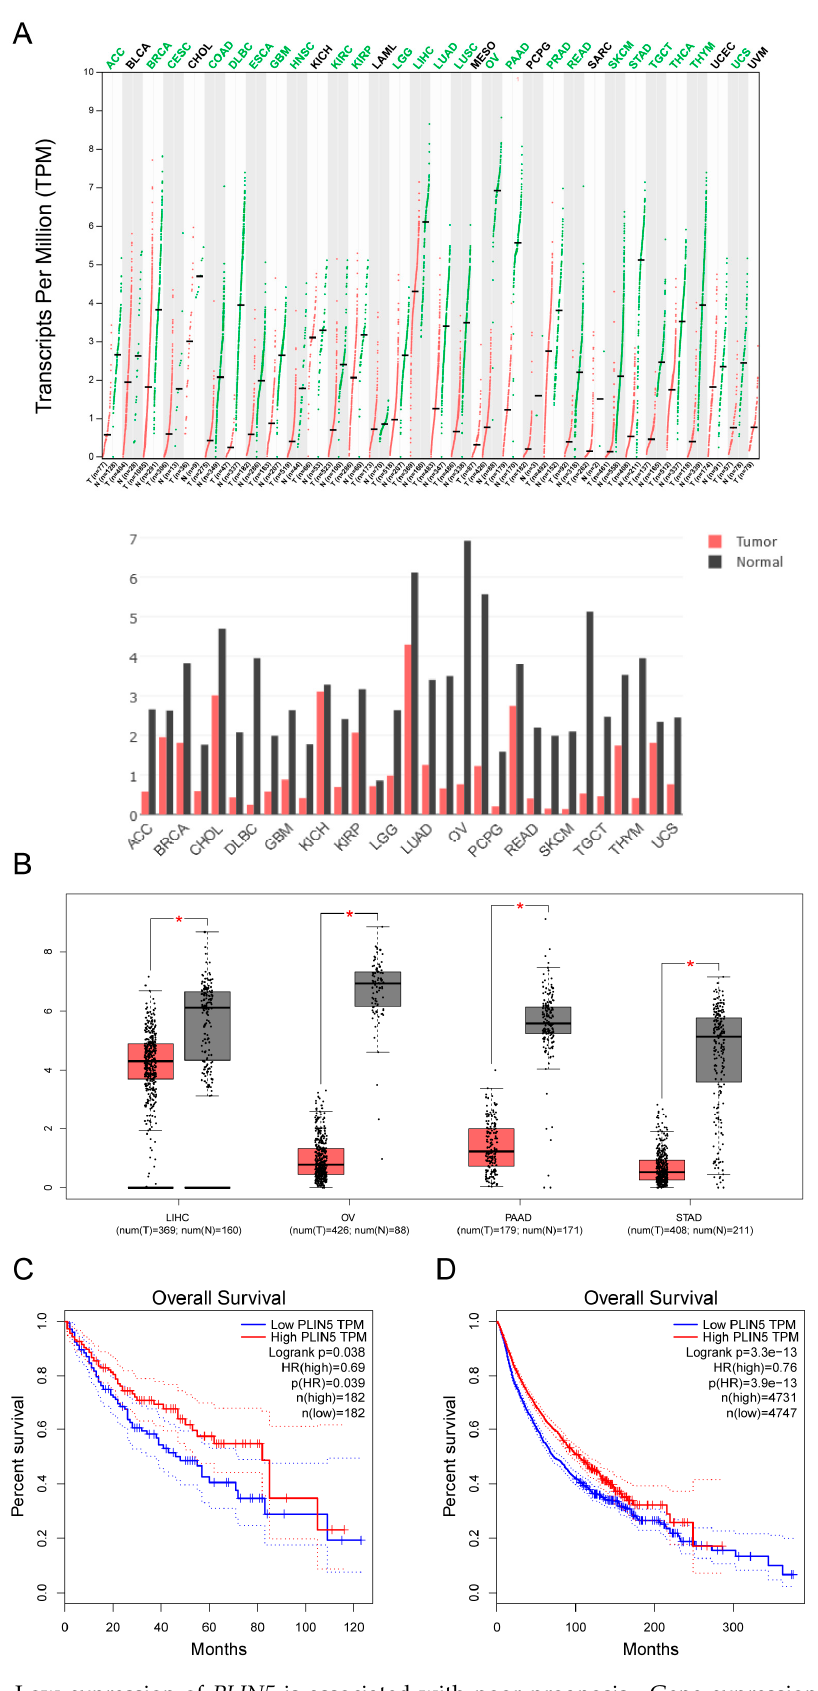
Figure 7. Low expression of PLIN5 is associated with poor prognosis. Gene expression analysis and survival analysis were performed using the GEPIA database (http: // gepia.cancer-pku.cn / ). ( A )